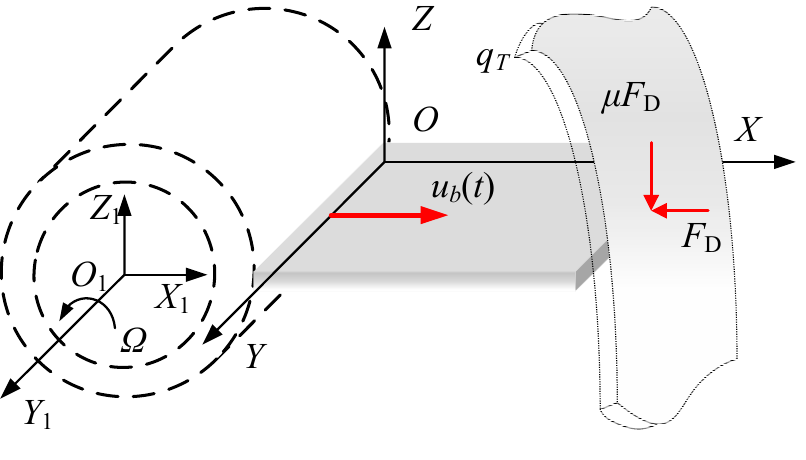
Figure 1. The rotating FGM plate .